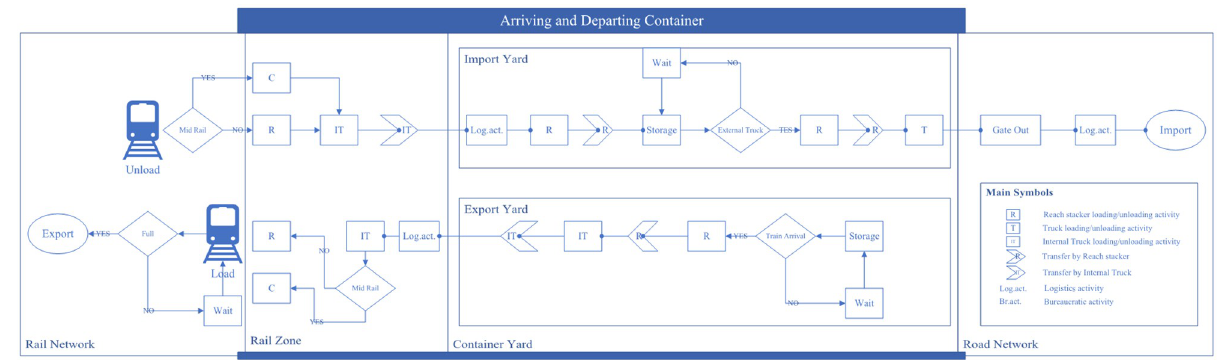
Fig 5. Operational flow of containers arriving and departing the LICD by trains.